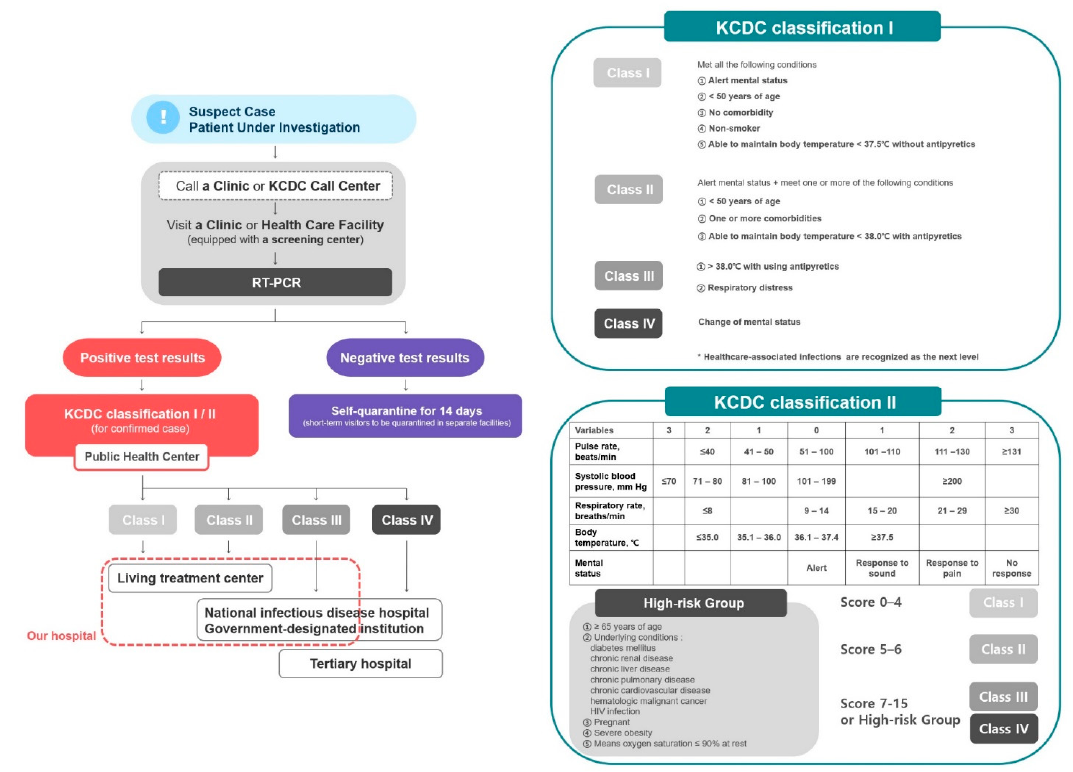
Figure 1. Triage algorithm and KCDC classification criteria for clinical severity of COVID-19 in South Korea. Abbreviations: KCDC, Korea Centers for Disease Control and Prevention; RT-PCR, real-time reverse transcription polymerase chain reaction Figure legend: The Living Treatment Center is a quarantine facility for mild or asymptomatic COVID-19 patients who are unable to self-isolate at home. The patients were checked for vital signs twice a day and immediately transferred to hospitals if their symptoms worsened. If their symptoms resolved, the patient was tested according to the standards for lifting the quarantine. Certain state-run facilities and accommodations are designated as Living Treatment Centers and are supplied with medical staff, medical equipment (pulse oximetry device, thermometer, blood pressure monitor, CPR kit, chest X-ray radiograph, etc.), individual relief kits (underwear, toiletries, face masks, etc.), and hygiene kits (thermometer and medical supplies).